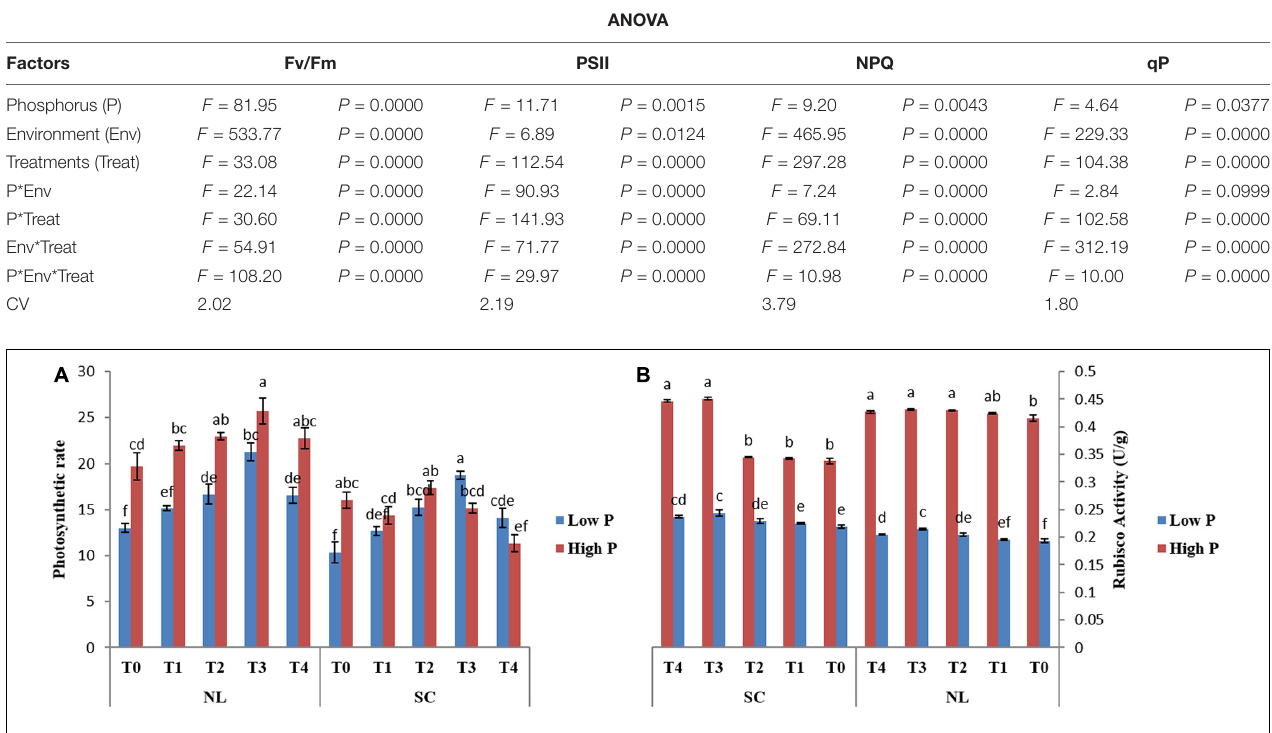
FIGURE 6 | Effect of Ti application on (A) photosynthetic rate and (B) Rubisco activity of soybean leaf under NL and SC combined with LP and HP conditions. The bar plots with different lettering show the significant difference among cultivars at probability < 0.05. The error bars are the ± SD values with n = 3.